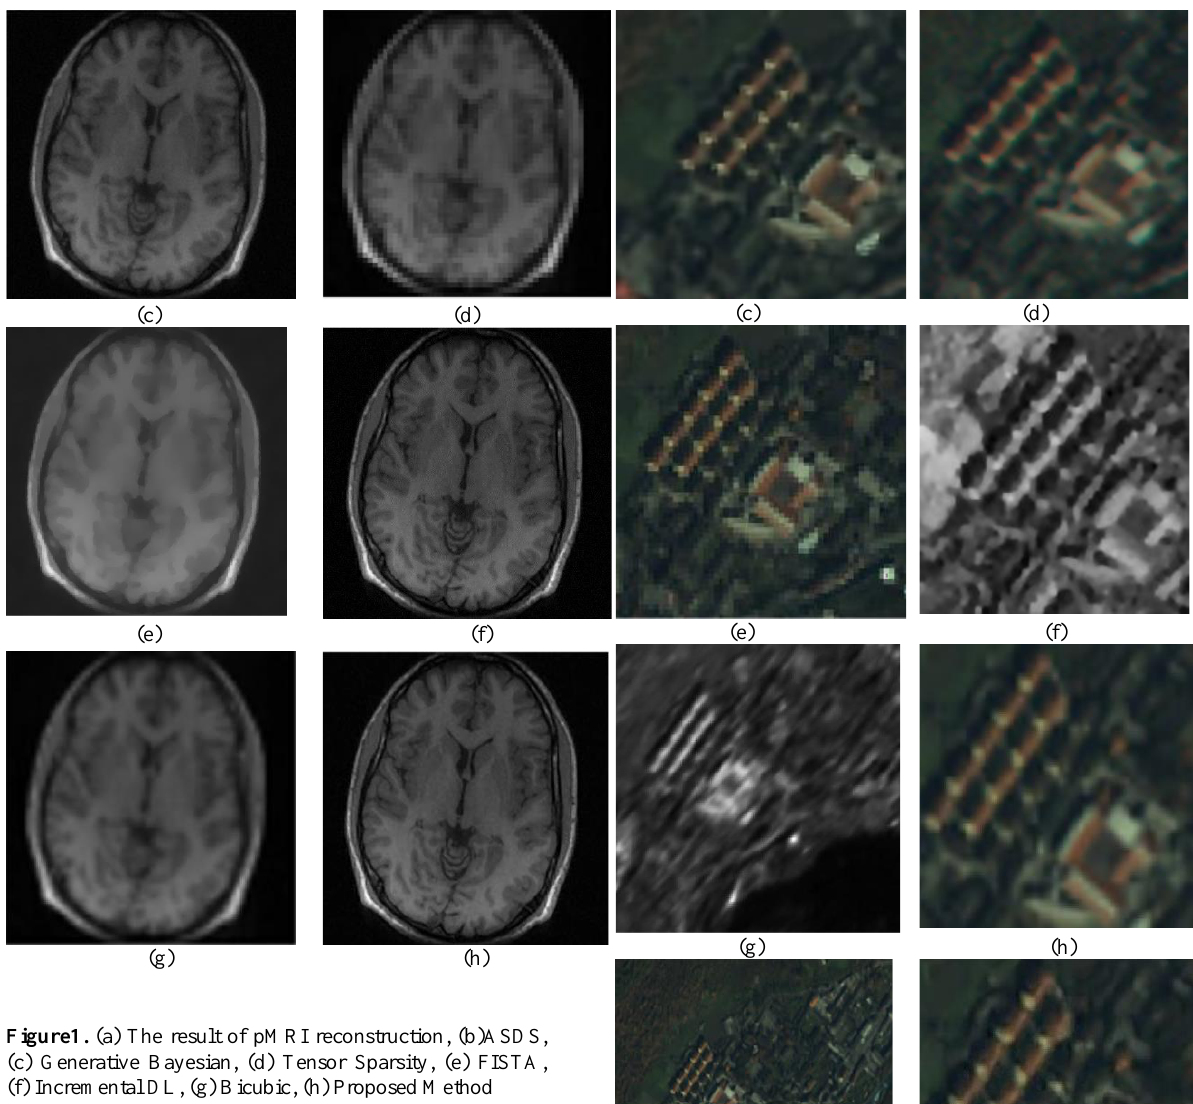
Figure2 . (a) original image, (b) 3times zoomed in, (c)ASDS, (d) Generative Bayesian, (e) Tensor Sparsity, (f) FISTA, (g) Incremental DL, (h) Bicubic, (k) Proposed Method, (l) 3times zoomed in proposed method’s